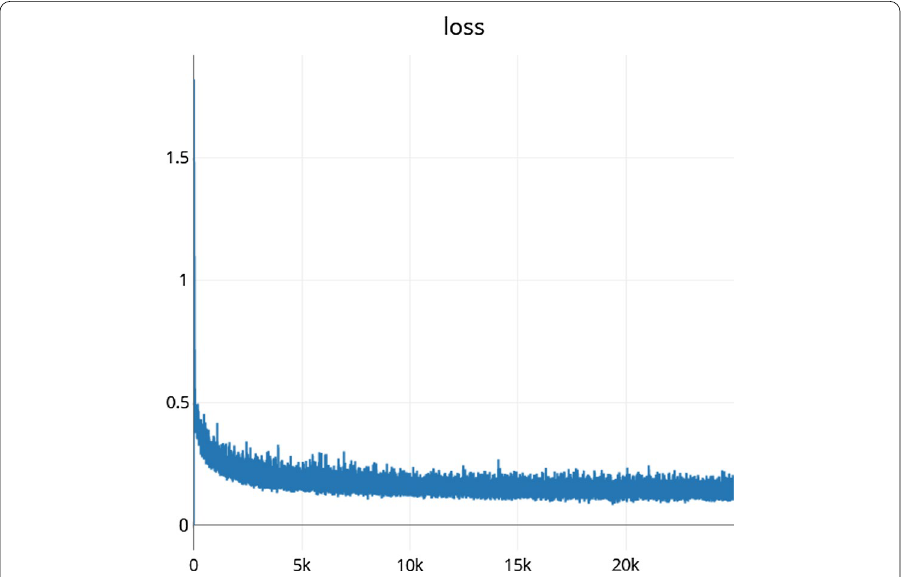
Fig. 12 The training process of the proposed